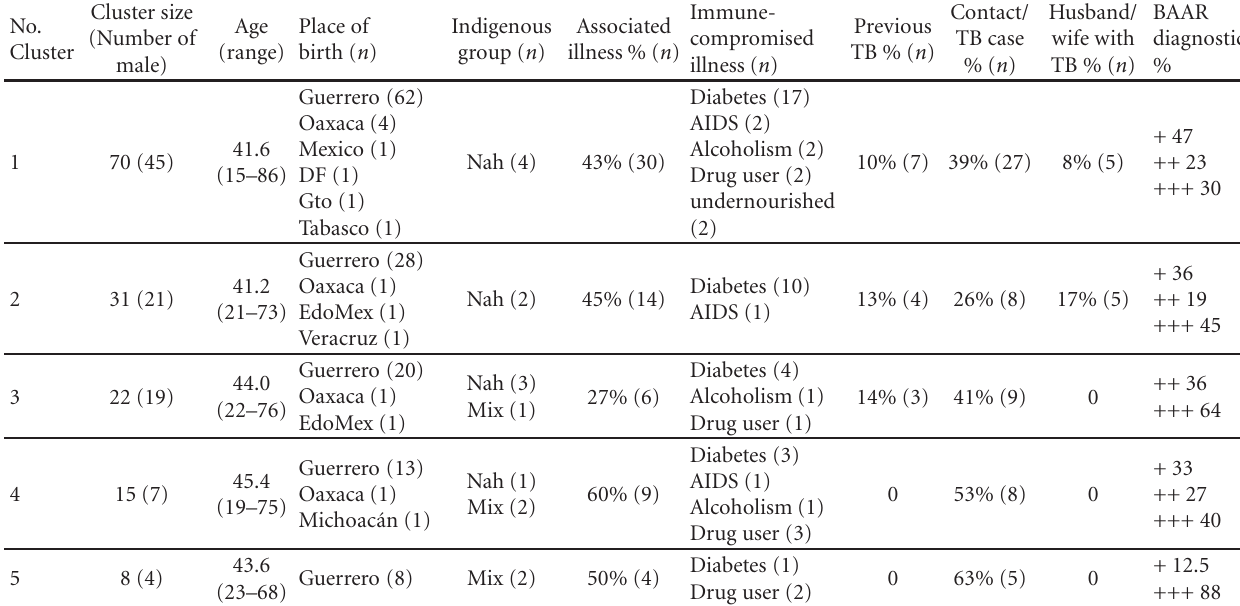
Table 4: Characteristics of the largest clusters detected by spoligotyping in